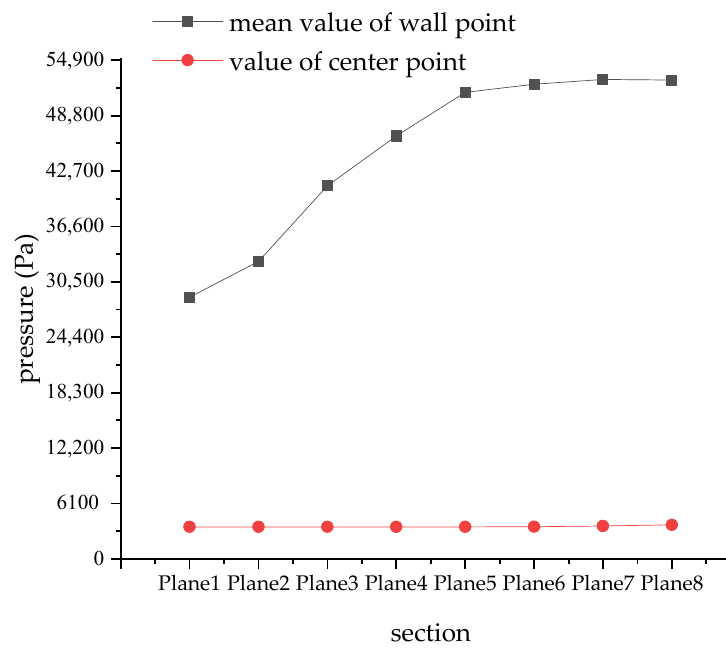
Figure 13. Pressure values of the different measuring points at t = 6.9 s.